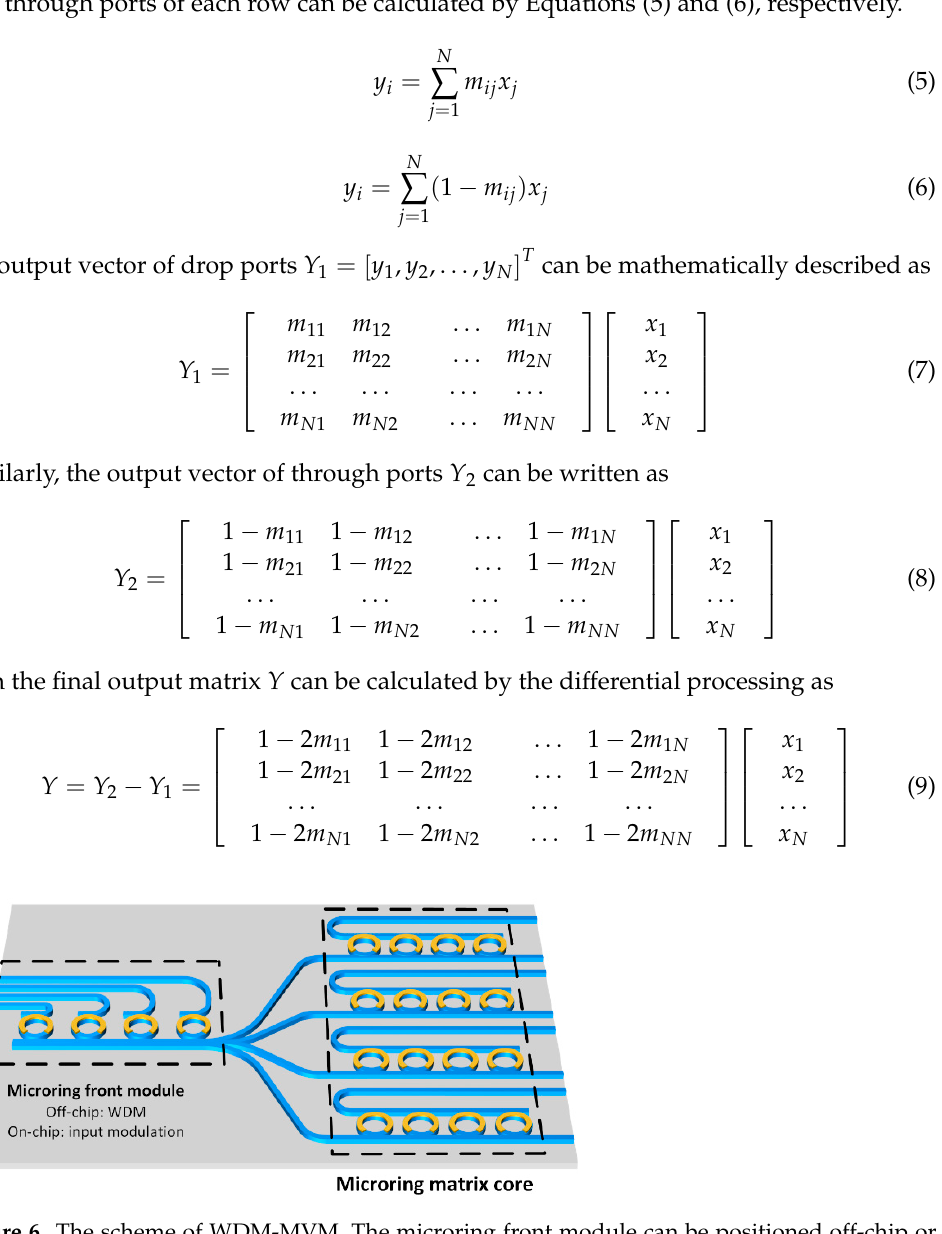
Figure 6. The scheme of WDM-MVM. The microring front module can be positioned off-chip or on-chip, which is designed to serve as a wavelength division multiplexer (off-chip) or to modulate the input vector X to different wavelengths (on-chip). The microring matrix core is an N × N -sized microring array corresponding to an N × N -sized